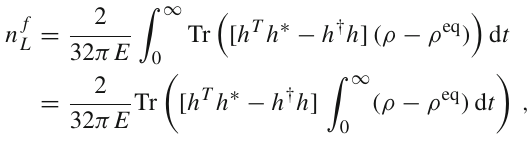
Fig. 1 Absolute value of the source term (left plots) and lepton asym- metry (right plots), as a function of time normalized to γ/ M 1 . The solid redlinescorrespondtotheEWPAapproach,thedashedblacklinestothe DMAusingEq.(8),thebluelineinthetoprightplottothemixingcontri- bution of theEWPA, and thedottedgreen linesinthebottom plotstothe standardclassicalapproachvalidinthehierarchicallimit.Inthetopplots we have chosen (cid:10) 1 / M 1 = 1 / 100, (cid:10) 2 / M 1 = 1 / 120 and (cid:7) M = (cid:10) 1 , while for the bottom plots, (cid:10) 1 / M 1 = 1 / 100, (cid:10) 2 / M 1 = 1 / 120 and